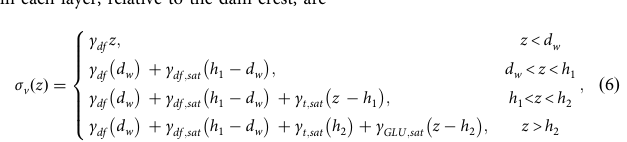
s ffiffiffiffiffiffiffiffiffiffi G max ρ